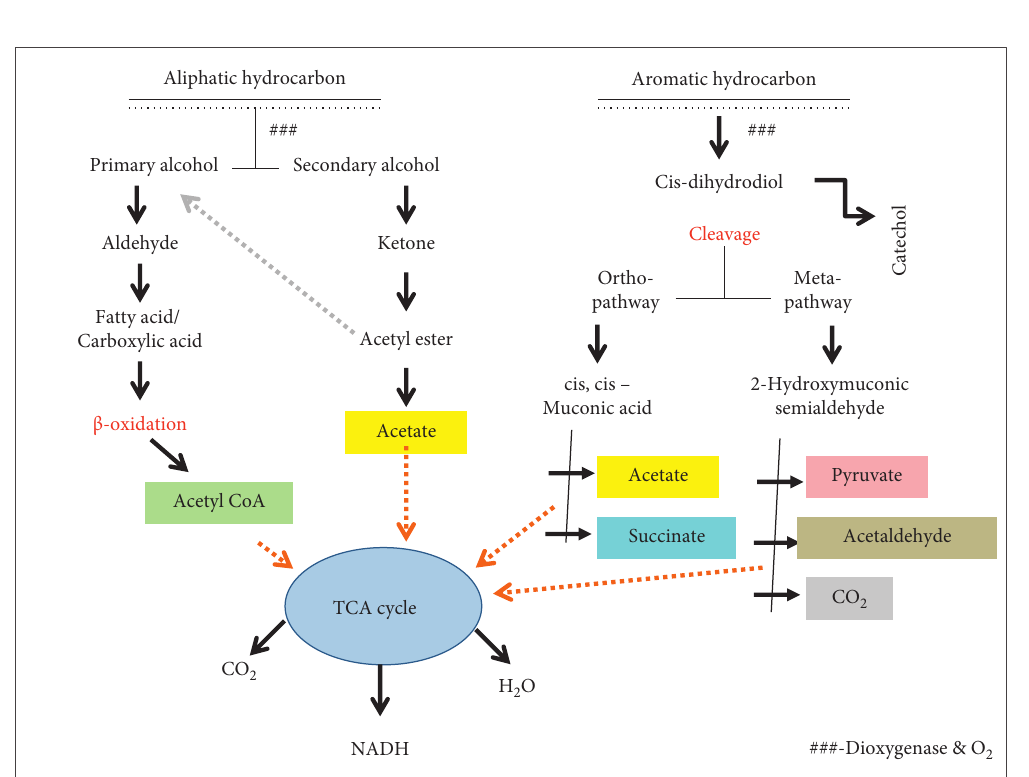
Figure 3: Bacterial metabolic pathways for the degradation of hydrocarbon contaminants